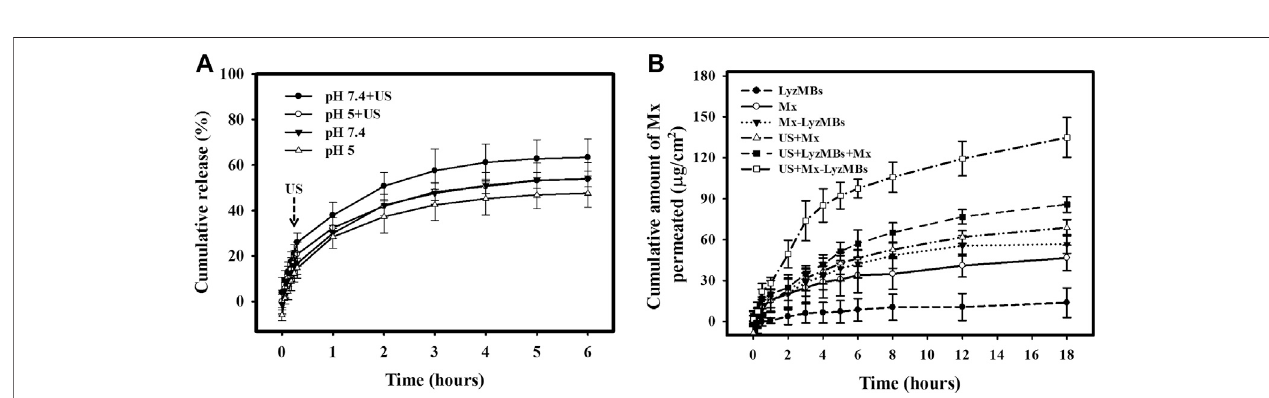
FIGURE 5 | (A) Comparative cumulative drug release of Mx after 6 h from Mx-LyzMBs with and without US exposure in PBS at pH 5 and 7.4. (B) In vitro drug penetration in the different experimental groups (see Tables 1, 2 ) through pigskin in a Franz diffusion cell at 36 – 37 ° C. Data are mean and SEM values.